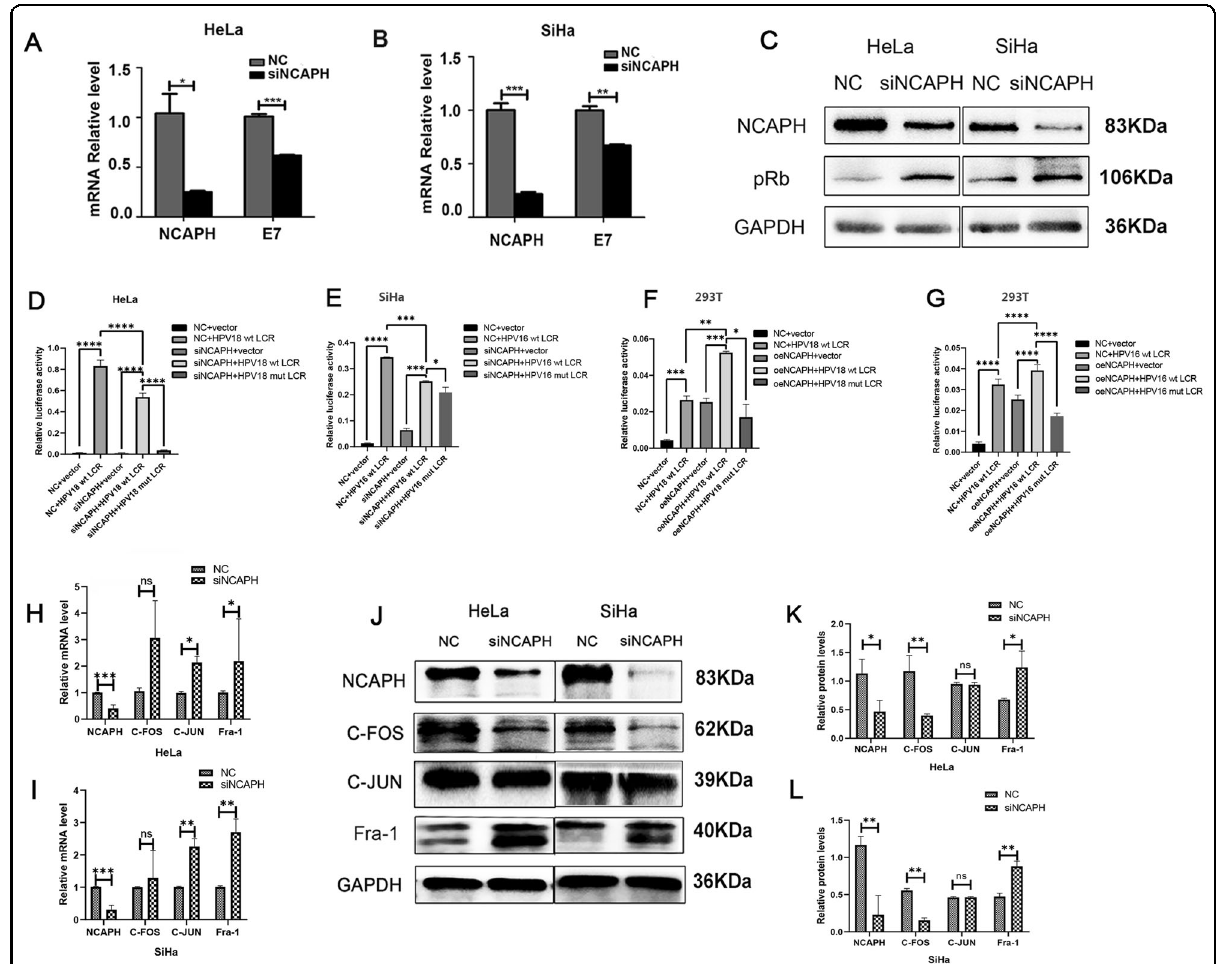
Fig. 6 NCAPH trans-modulates the transcription of HPV E7 through the conversion of AP-1 components. A , B Real-time PCR showed that silencing NCAPH expression signi fi cantly decreased the mRNA level of E7 in HeLa and SiHa cells. C Western Blot analysis showed that knockdown of NCAPH increased the protein expression of pRb. D , E Luciferase assay showed the changes of fl uorescence intensity after transfection in HeLa and SiHa cells. NC, negative control; siNCAPH, siRNA targeting NCAPH; vector, pGL3-Basic vector; HPV 18/16 wt LCR, pGL3 vector inserted with the wild type LCR; HPV 18/16 mut LCR, pGL3 vector inserted with the mutated LCR (mutation in the binding site of AP-1). H , I Luciferase assay showed the changes of fl uorescence intensity after transfection in 293T cells. NC, mock vector; oeNCAPH, NCAPH over-expression plasmid. F , G Real-time PCR showed that mRNA levels of c-Fos, c-Jun, and Fra-1 were increased signi fi cantly after siNCAPH transfection in HeLa and SiHa cells. H – L Western Blot analysis showed that after silencing NCAPH expression in HeLa and SiHa cells, c-Fos protein expression was down-regulated, however Fra-1 protein levels were upregulated signi fi cantly. NC, negative control siRNA; siNCAPH, siRNA targeting NCAPH gene. Data are presented as mean ± SD ( n = 3). * represents p < 0.05, ** represents p < 0.01, *** represents p < 0.001; ns not signi fi